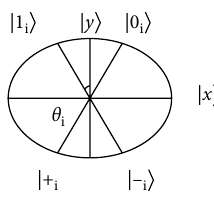
Figure 1: Nonorthogonal quantum